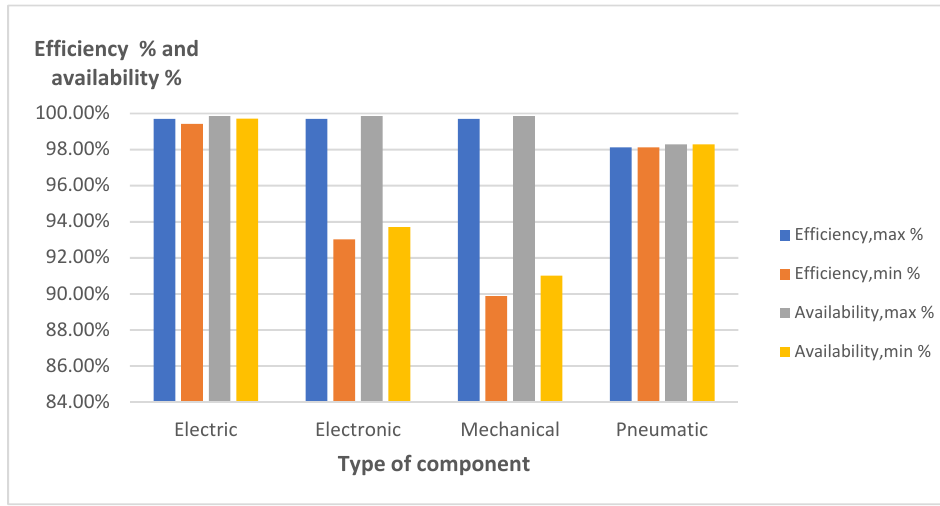
Figure 4. Maximum and minimum efficiency and availability values in % by type of component with the PPM strategy.